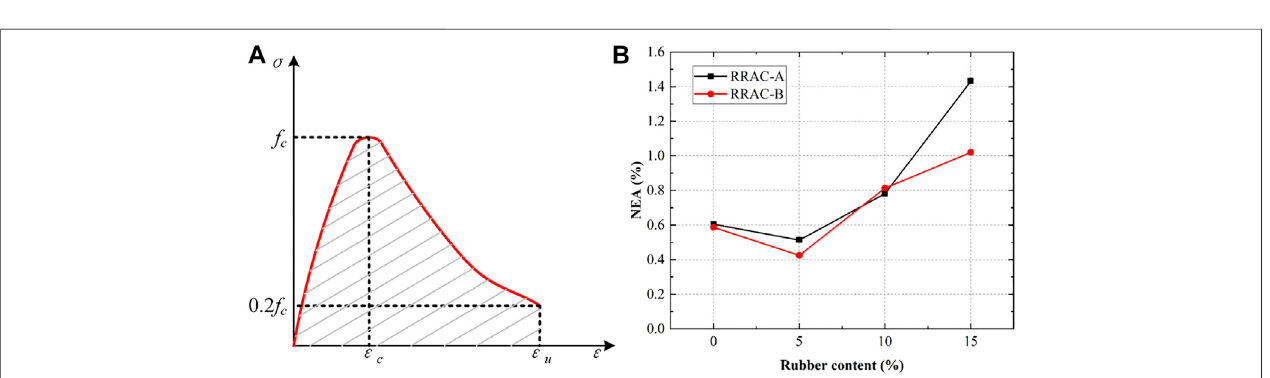
FIGURE 7 | Calculation method and NEA of RRAC: (A) Calculation method of energy absorption; (B) NEA of RRAC under different rubber content.